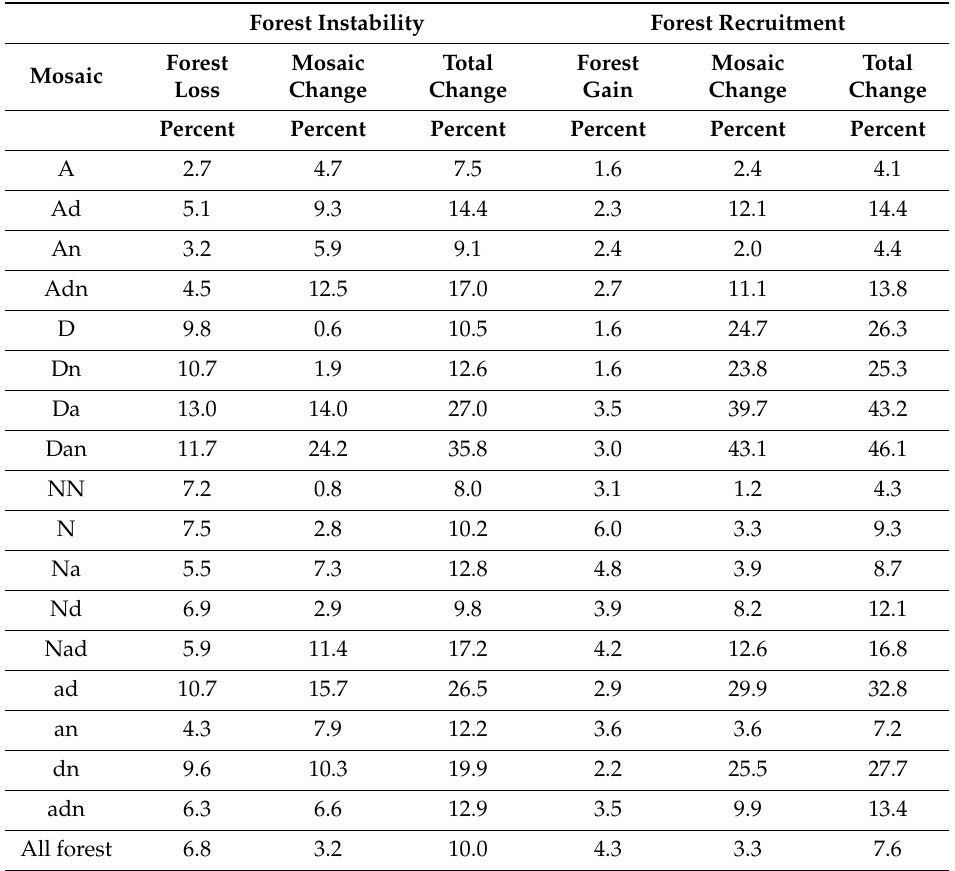
Table 4. Components of forest area instability and recruitment from 2001 to 2016, by mosaic class. Recruitment and instability (the complement of persistence) are defined in the text. The components of total change include either forest gain or forest loss, and the change of mosaic class for area that was forest at both dates. The AA and DD mosaics are not shown because they contain no forest.